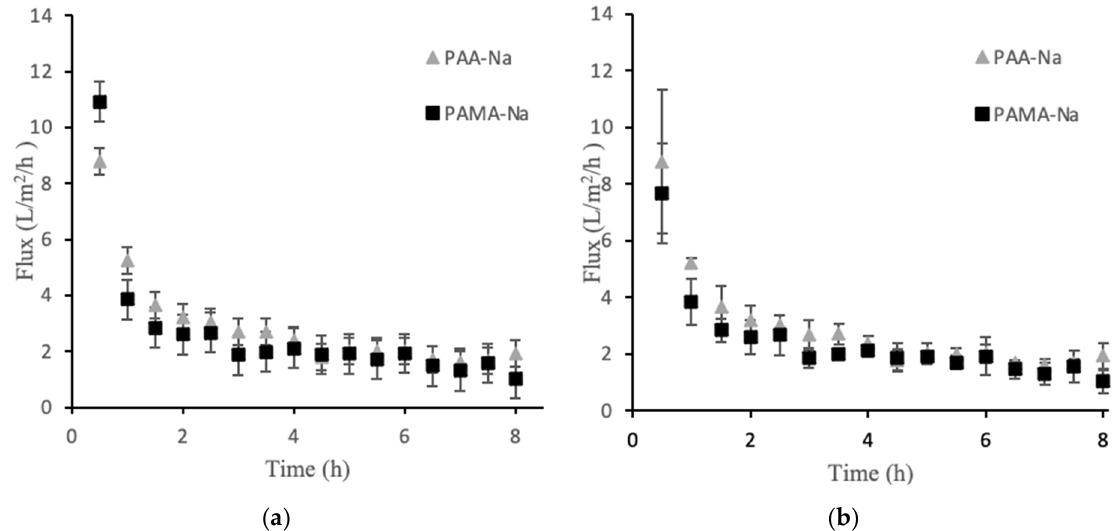
Figure 1. Direct flow flux decline data for PAA-Na and PAMA-Na at concentrations of 0.3 g/mL ( a ) and 0.5 g/mL ( b ). Error bars represent ± 1σ generated from three experiments.